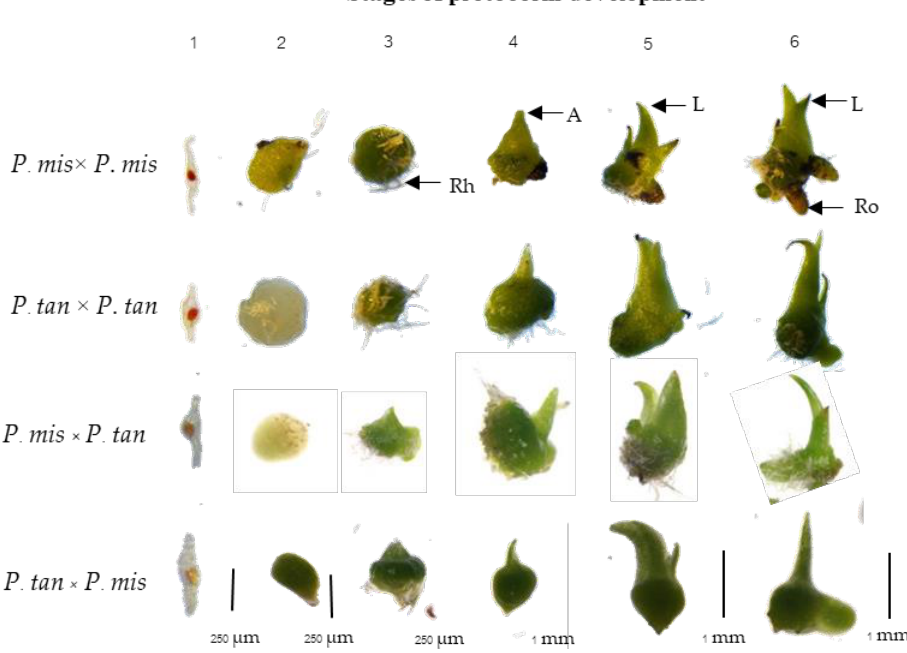
Figure 1. Protocorm development stages after asymbiotic seed germination of P . mishmensis and P . tankervilliae and interScheme 1. No development of seed; Stage 2, embryo enlargement and rupture from the testa; Stage 3, appearance of rhizoids (Rh) (germination); Stage 4, apical meristem (A) production; Stage 5, emergence of the leaf (L); Stage 6, emergence of the root (Ro). Table 3. Protocorm development of intra- and interspecific hybrids of P. mishmensis (M) and P . tankervilliae (T) after cultured on VW medium for 16 weeks.